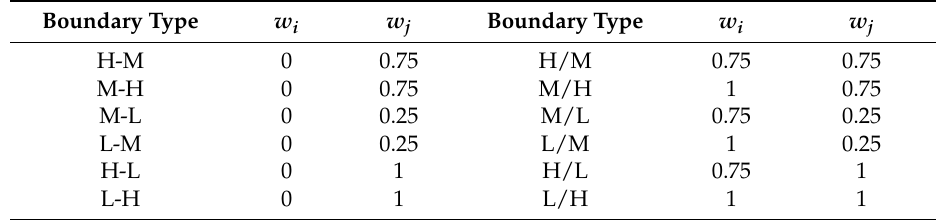
Table 2. Weights of boundary types. ’H’, ‘M’ and ‘L’ are symbols of canopy height ranks shown in Table 1. (‘-’ represents a west-east orientation; ’/’ represents a north-south